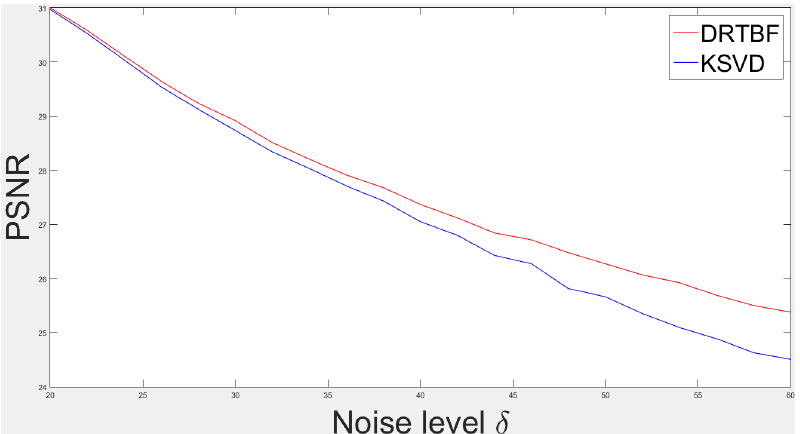
Figure 1. Robustness Analysis. DRTPF is trained and tested using the image ’Barbara’. The X -label is the noise level δ and the Y -label is the PSNR. It can be seen that DRTPF performs more robustly than K-SVD.